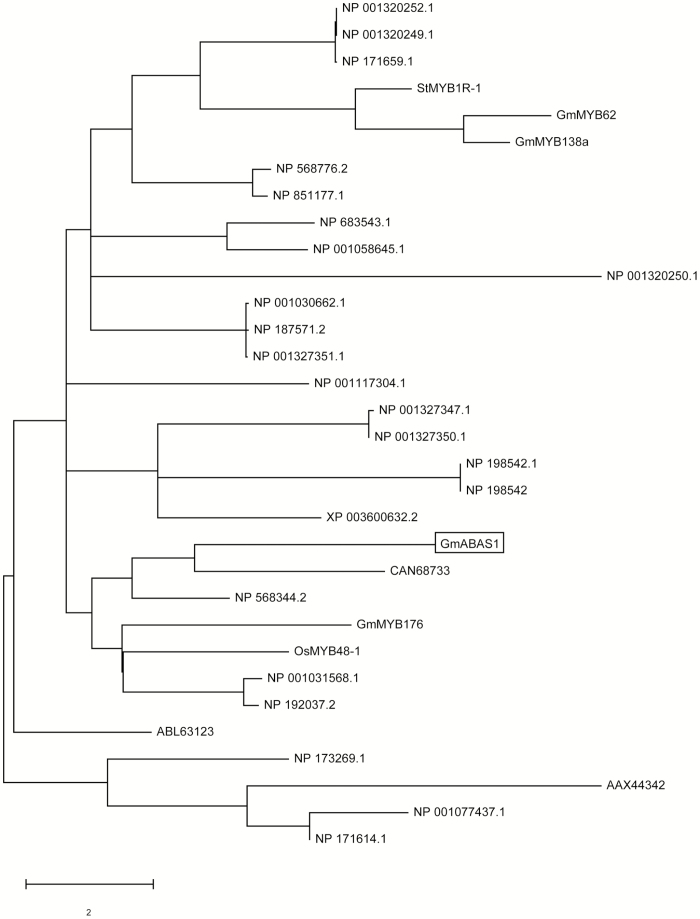
Phylogenetic study of GmABAS1, selected homeodomain-like proteins from A. thaliana and 1R MYB proteins from plants. The amino acid sequences of the proteins were aligned for the construction of the phylogenetic tree using MEGA7. Homeodomain-like proteins from A. thaliana: NP_187571.2, NP_001327351.1, NP_001030662.1, NP_001327347.1, NP_001327350.1, NP_568776.2, NP_851177.1, NP_171659.1, NP_001031568.1, NP_192037.2, NP_001320252.1, NP_001320249.1, NP_001320250.1, NP_198542.1, NP_001077437.1, NP_171614.1, NP_568344.2, NP_173269.1, NP_683543.1, and NP_001117304.1. Proteins from various plant species which were found to contain the 1R MYB domain: CAN68733 (from Vitis vinifera), XP_003600632.2 (from Medicago truncatula), AAX44342 (from Solanum peruvianum), ABL63123 (from Catharanthus roseus), NP_001058645.1 (from Oryza sativa), and NP_198542 (from A. thaliana). Characterized 1R MYB proteins from various plant species: StMYB1R-1, OsMYB48-1, GmMYB176, GmMYB62, and GmMYB138a. GmABAS1 is enclosed in a box.